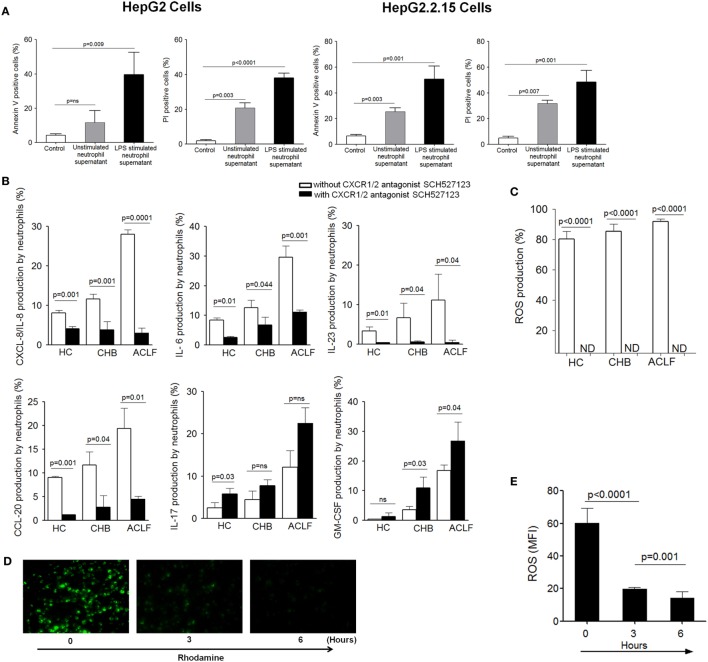
Blocking of CXCR1/2 receptors inhibit production of neutrophil’s inflammatory mediators and reduce cell death. (A) Culture of HepG2 and HepG2.2.15 cells with resting and LPS-activated neutrophil’s supernatant (from ACLF patients) resulted in marked apoptosis and necrosis of both cell types. (B) CXCR1/2 blockade showed significant reduction in inflammatory cytokines/chemokines, including CXCL8/IL-8, IL-6, IL-23, and CCL20. However, GM-CSF and IL-17 was increased. Bar graphs demonstrate cytokines production after LPS stimulation (C) To investigate the effect of CXCR1/2 blockade on reactive oxygen species (ROS) production, cells were stimulated with E. coli for 18 h, and production of ROS was measured. Bar graph illustrates significant reduction in ROS after CXCR1/2 blockade. (D) Immunofluorescence confirmed significant reduction in ROS which started at 3 h completely depleted at 18 h (magnification: 20×) (n = 15). (E) MFI of ROS was calculated at different time point after CXCR1/2 blockade and shown in bar graph.